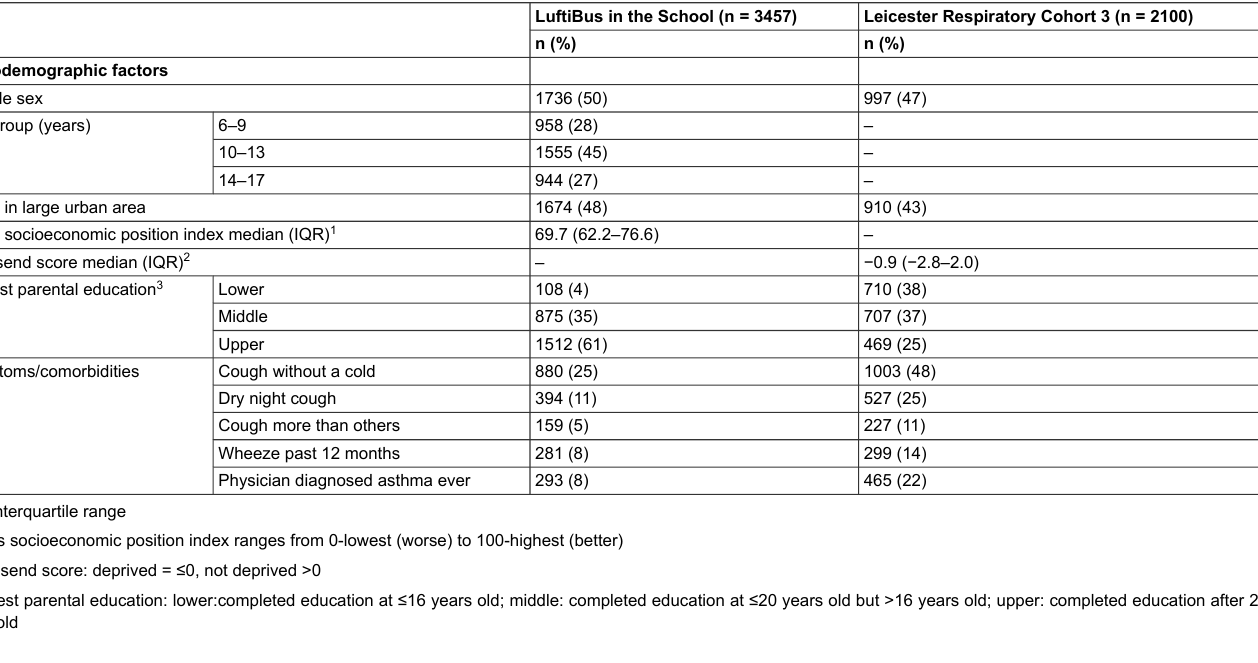
Table 1: Characteristics of children from the LuftiBus in the School study and Leicester Respiratory Cohort included in this analysis.